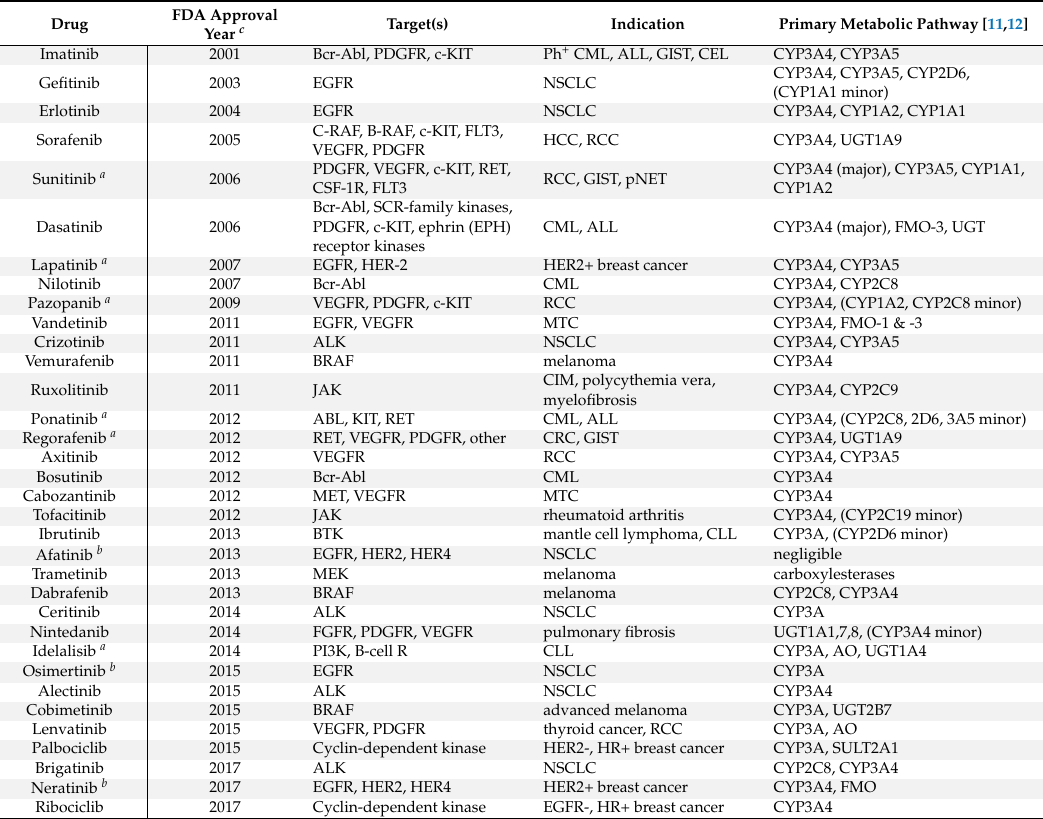
Table 1. Summary of Kinase Inhibitors Approved for Clinical